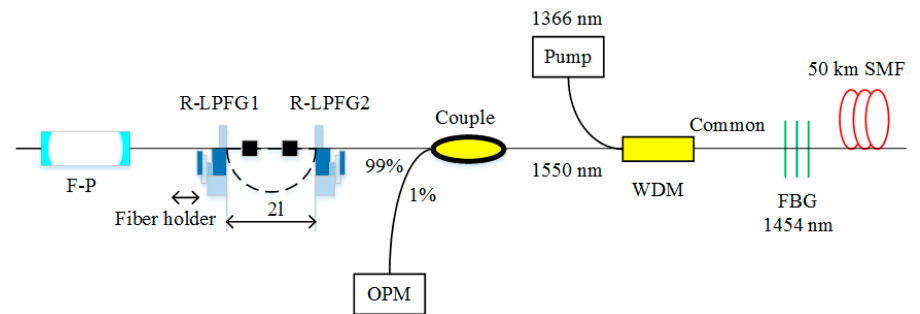
Figure 12. Experimental setup for the tunable multi-wavelength RFL.